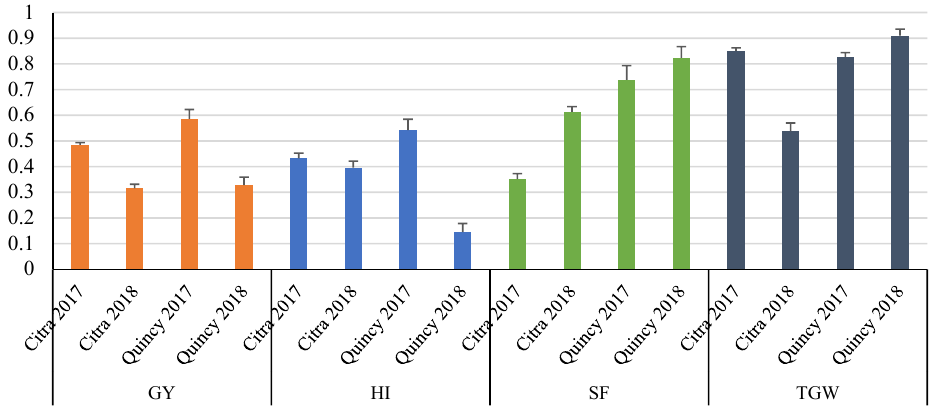
Figure 6. Prediction accuracies for GY (t ha − 1 ), HI (%), SF (grains/g chaff weight), and TGW (g) across environments using the BMOR model. GY, grain yield; HI, harvest index; SF, spike fertility; TGW, thousand grain weight. Mean Pearson’s correlations and standard error for each environment were presented for each trait. The results of GY, HI, SF, and TGW trait were colored in orange, blue, light green, and blue ‐ gray.